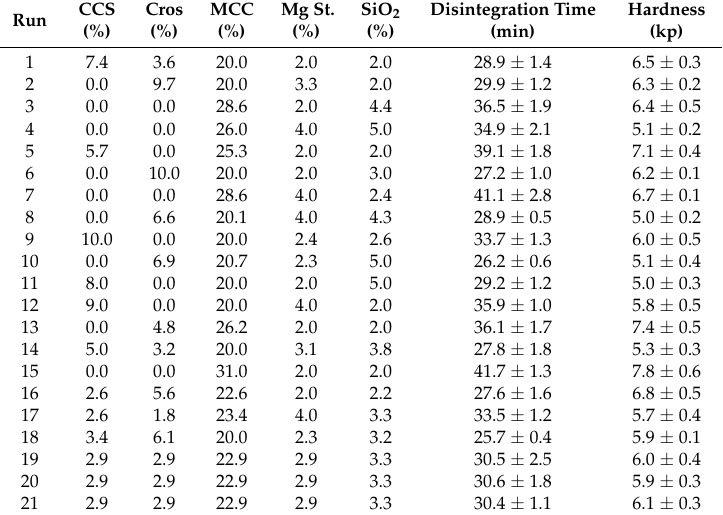
Table 5. Experimental design of herbal tablet formulation containing 65% Wuzi Yanzong dry powder extract with five control factors (%, w / w ) and the resulting response, disintegration time, and hardness.